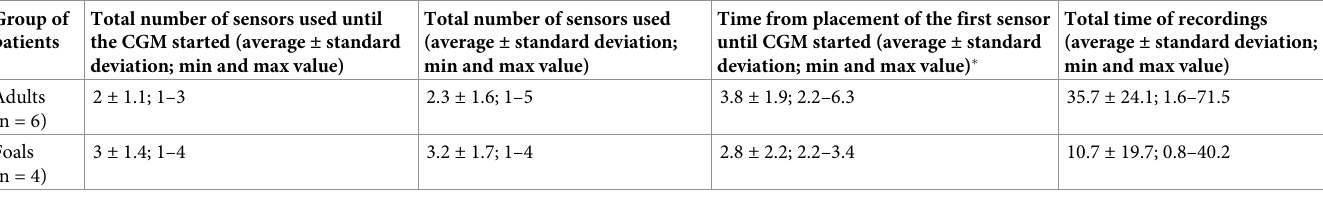
Table 1. Overview of the number of sensors used and recording times. Group of